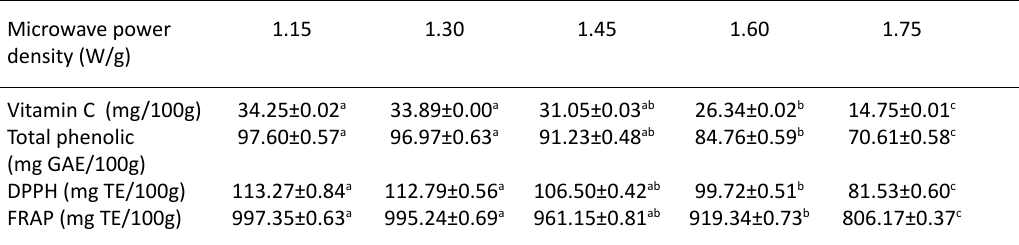
Values are the average of triplicate; numbers in row accompanied by the alike symbols are not varied significantly (α = P=0.05). table 7. Impact of microwave energy in microwave-air dehydration to phenolic content and antioxidant capacity in dried